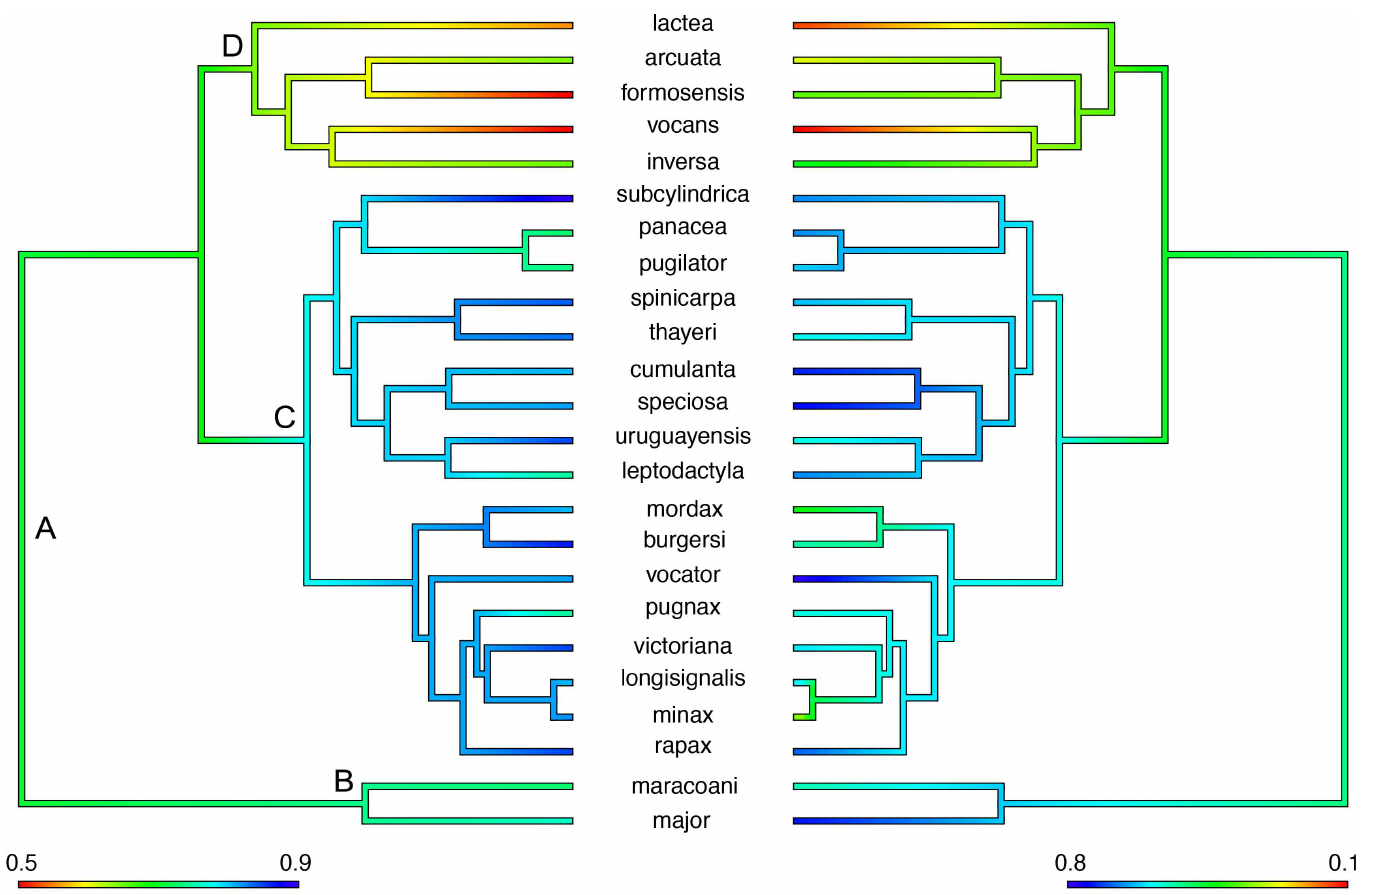
Fig 5. Estimation of ancestral states by maximum likelihood analysis for hyper- and hypo-osmoregulatory indices (left and right panels, respectively) in the fiddler crab topology modified from Shih et al. (2015). Indices close to 1 reflect substantialability to regulatehemolymphosmolality againstvariationin external osmolality; values near 0 revealvery limited regulatoryability, reflecting restricted capabilityto maintain hemolymph osmolality. The evolutionof the two indicesis not correlated(PGLS slope = 0.11, F = 1.7, P < 0.81, α = 0.6), and neither index is linked to habitat osmolality(PGLS slope (cid:25) 0.0, 0.8 (cid:20) F (cid:20) 3.3, 0.1 (cid:20) P (cid:20) 0.4, 0.3 (cid:20) α (cid:20) 1.7). However, an association betweenthe indicesis revealedat more inclusivelevels. A, B, C and D are natural groupingsparticularly relevant to the interpretation of osmoregulatory evolution[A, genus Uca ; B and C, Americanclades; D, Indo-west Pacific